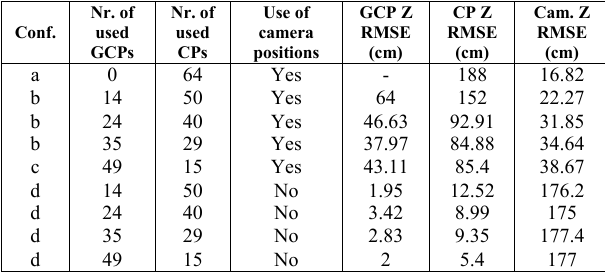
Table 4. Altimetric Z RMSEs(cm) in different bundle- adjustment